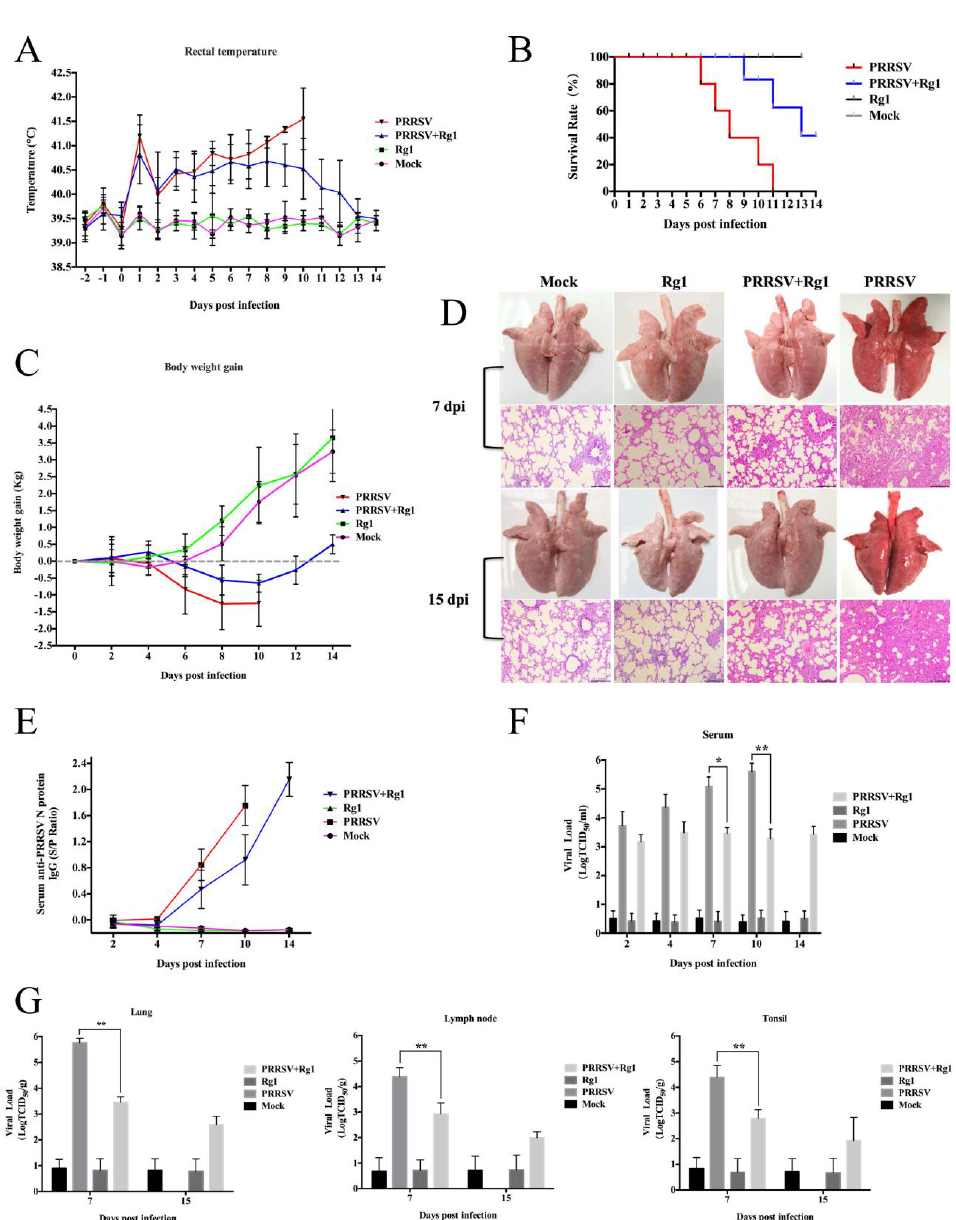
Figure 6. Rg1 exhibits anti-PRRSV activity in 4-week-piglet. ( A ) Daily rectal temperature of the